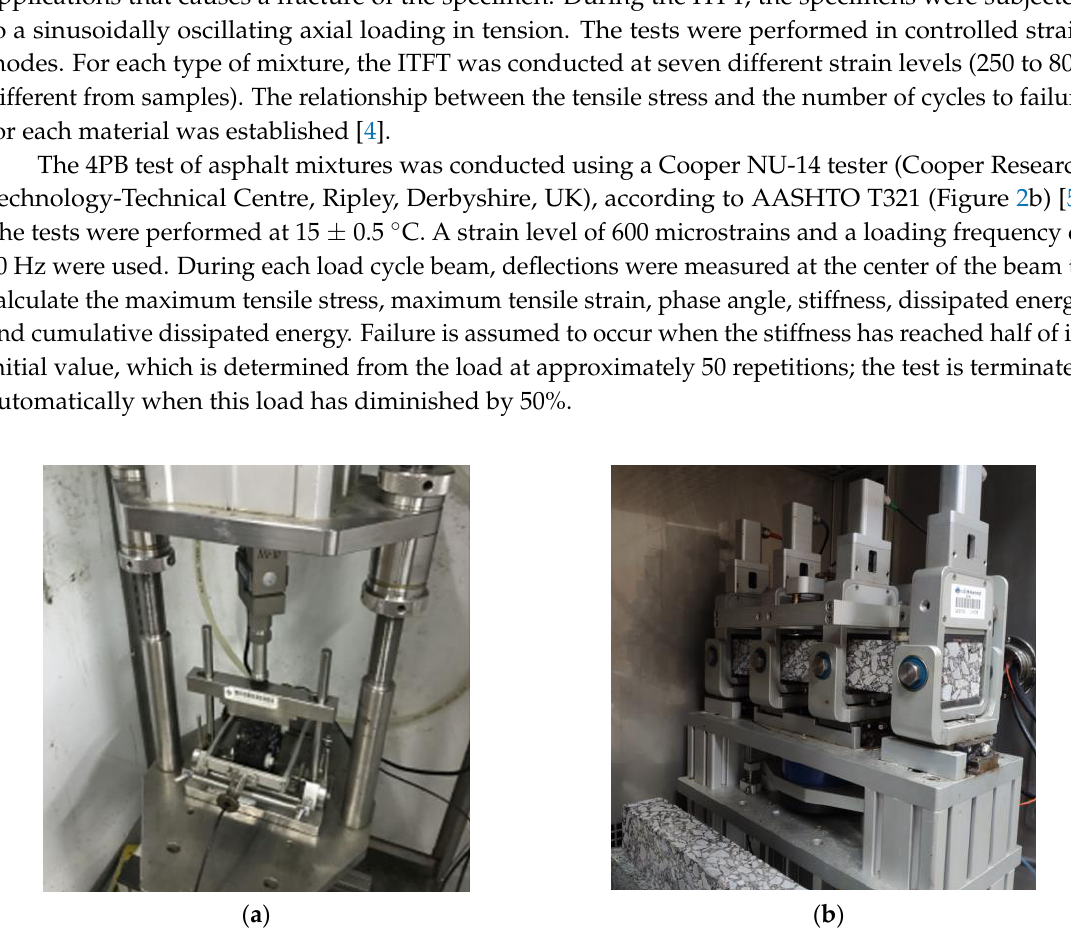
Figure 1. Fatigue characterizing tests: ( a ) G*sinδ and linear amplitude sweep (LAS) test for binders; ( b ) shear fatigue test for mortars.